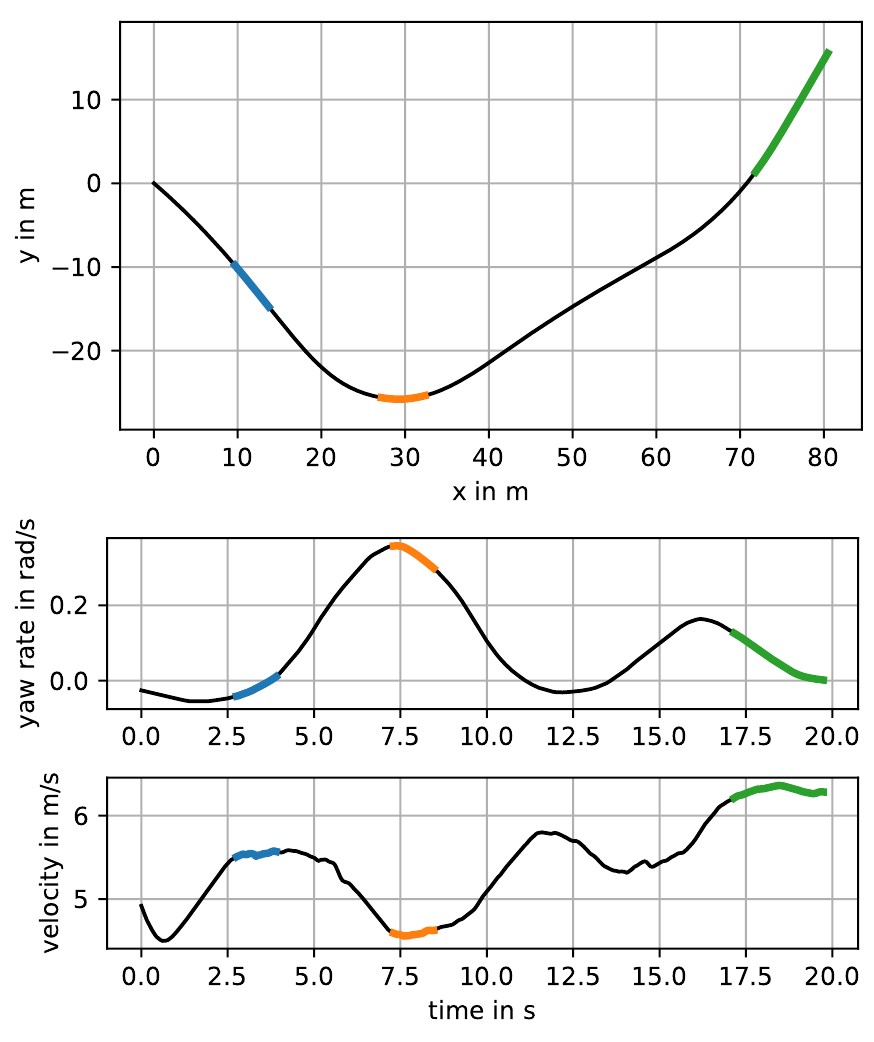
Figure 3. Trajectory data with the parts detected to be a trim trajectory marked using different